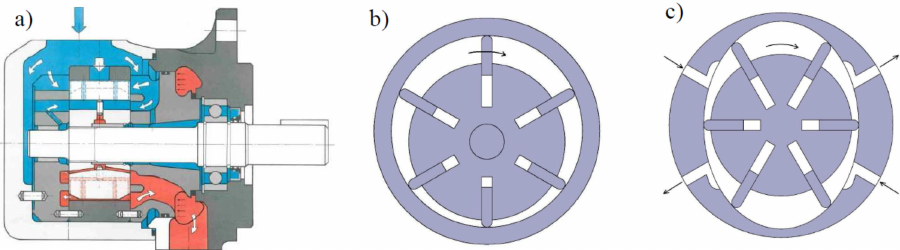
Figure 1. The vane pump: ( a ) Cross-over; ( b ) Single-acting; ( c )